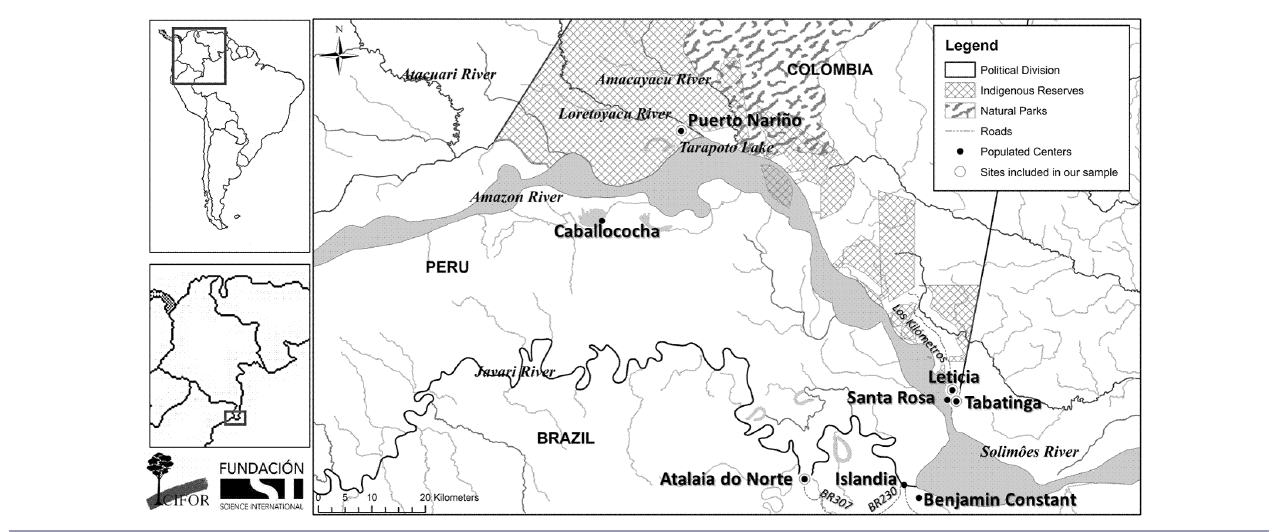
Fig. 1 . Map of the study area indicating the towns